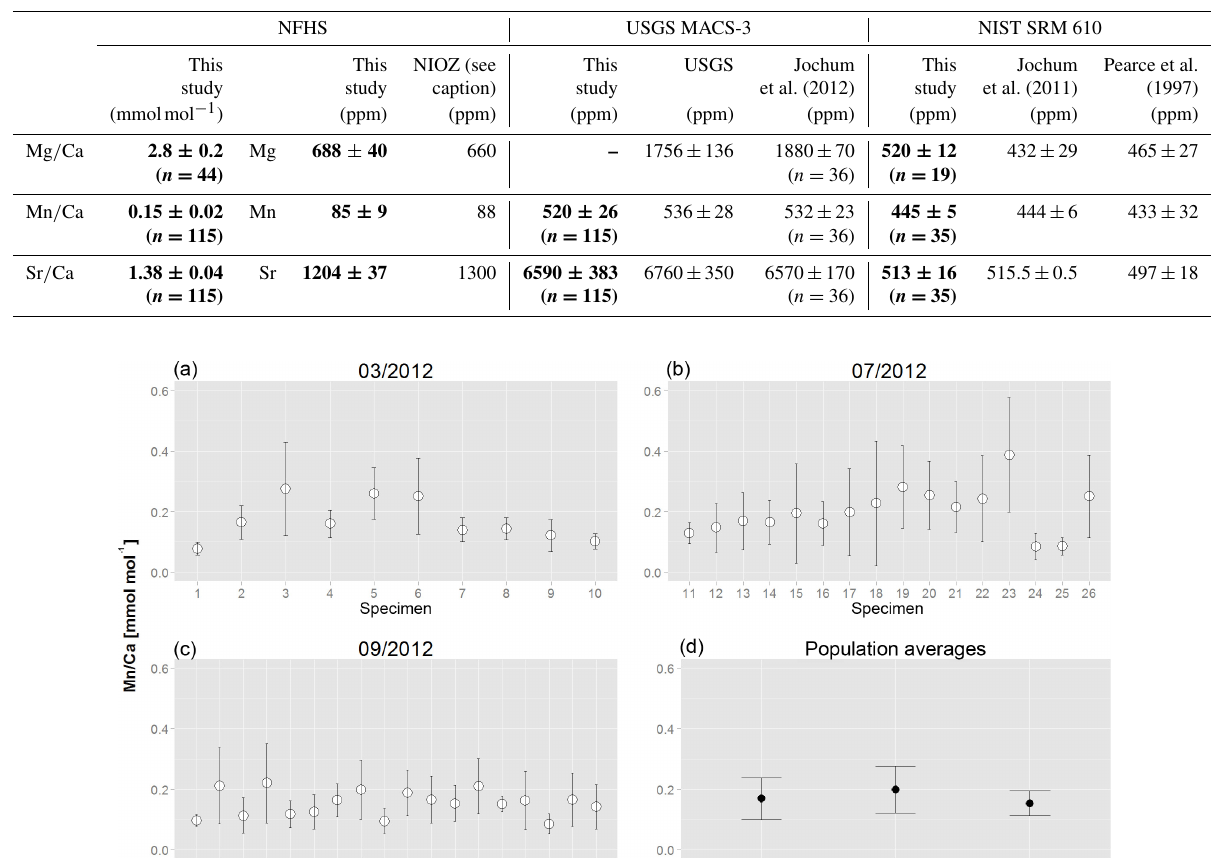
Table 2. Evaluation of external reproducibility of laser ablation ICP-MS analyses for Mg / Ca, Mn / Ca and Sr / Ca determined on the NFHS, USGS MACS-3 and NIST SRM 610. For Mn / Ca and Sr / Ca, all values are calibrated against NIST SRM 612 and are given as average with SDs from all sessions (in bold). For Mg / Ca, all values are calibrated against USGS MACS-3. Reference values with SD are given according to Jochum et al. (2011), Jochum et al. (2012), USGS (S. Wilson, USGS, unpublished) and Pearce et al. (1997). Values for NFHS are in mmolmol − 1 for better comparison with results from samples (SD of standard applied as error bar on samples) as well as in ppm because reference values are given in this unit (information obtained from the NIOZ, 2017) and for comparison with concentrations of other reference materials. Values for USGS MACS-3 and NIST SRM 610 are in ppm for comparison with published reference values.